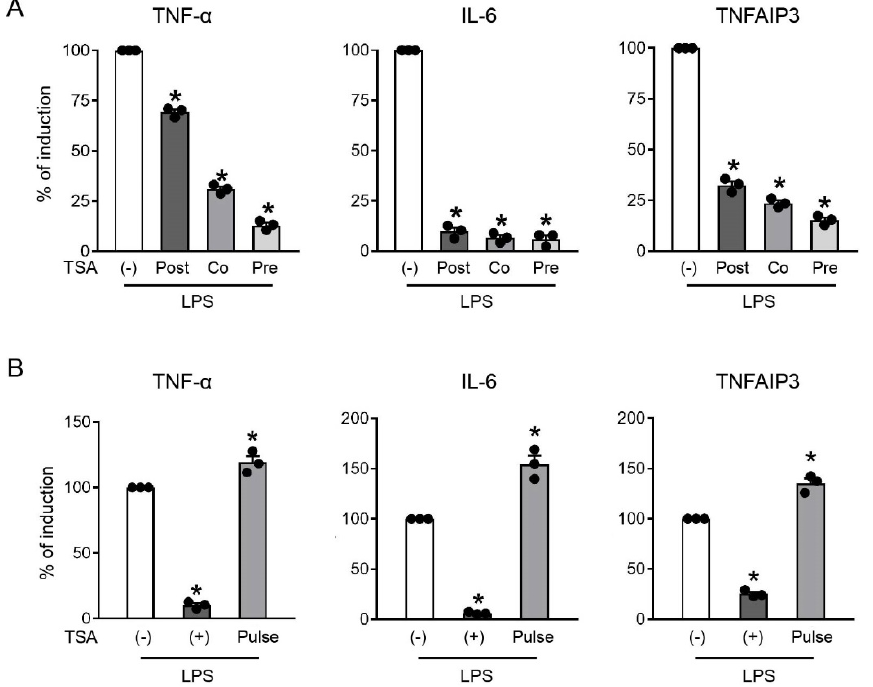
Figure 2. mRNA i nhibition by TSA was rapid and reversible. ( A ) RAW246.7 cells were treated or not (-) with 100 ng/mL TSA for 30 min before (Pre), together (Co) or 30 min after (Post) LPS stimulation (1 µg/mL, 120 min) prior to mRNA extraction. ( B ) RAW246.7 cells were pre-treated or not (-) with 100 ng/mL TSA for 30 min and then stimulated with 1 µg/mL LPS for 120 min. TSA was either left during the stimulation (+) or removed via extensive washing before the LPS stimulation (Pulse). The regulation of TNF- α , IL-6 and TNFAIP3 was investigated at the mRNA level using RT-PCR. Data were normalized to the housekeeping RNA (18S) and expressed as mean ± SEM ( n = 3) of the percentage of production in samples stimulated with LPS alone (-). * p < 0.05 versus LPS alone (-) using an unpaired t -test. Dots represent results of individual experiments.